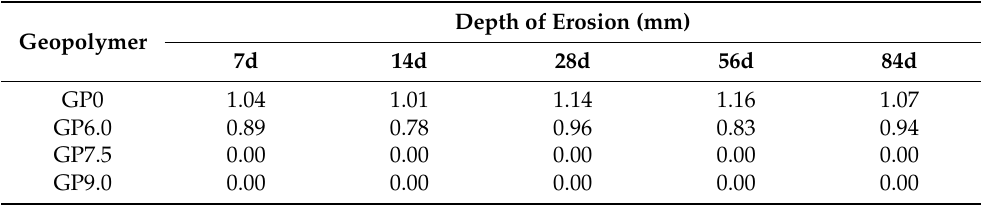
Table 5. Depth of erosion of geopolymers after different durations of exposure.